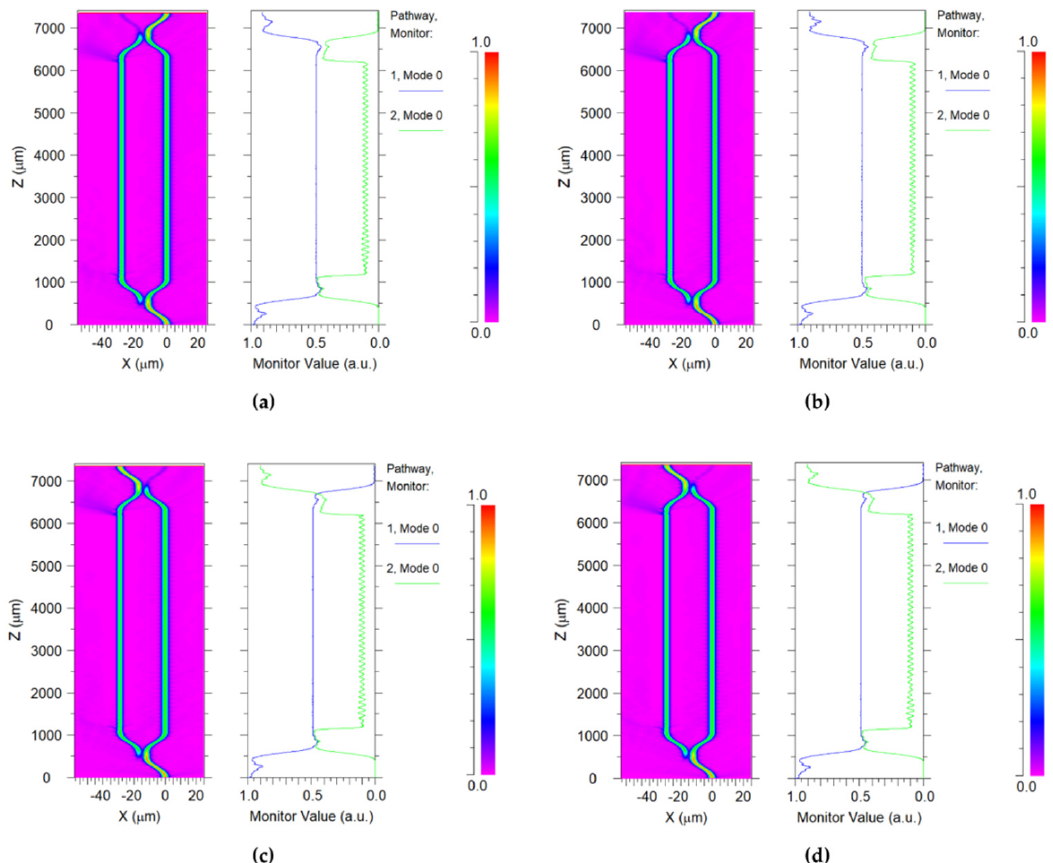
Figure 8. Simulated optical distribution for ( a ) TE mode and ( b ) TM mode when no driving power was applied to the heater, and for ( c ) TE mode and ( d ) TM mode when driving power was applied to the heater.